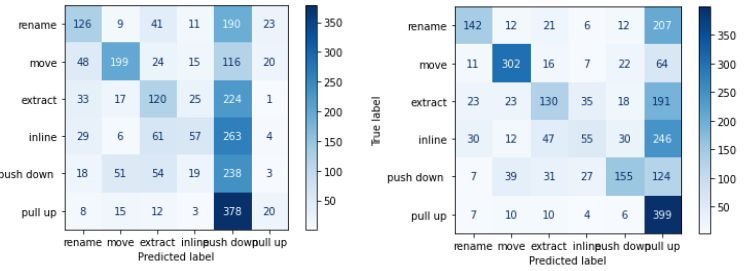
Figure 6. Confusion Matrix for naive Bayes classifier and logistic regression classifier (Metrics only).